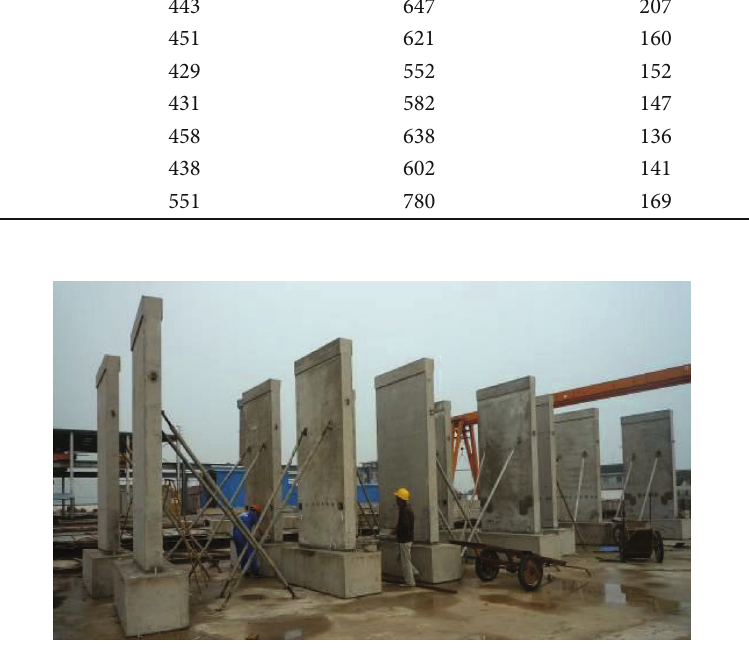
Figure 2: Assembled